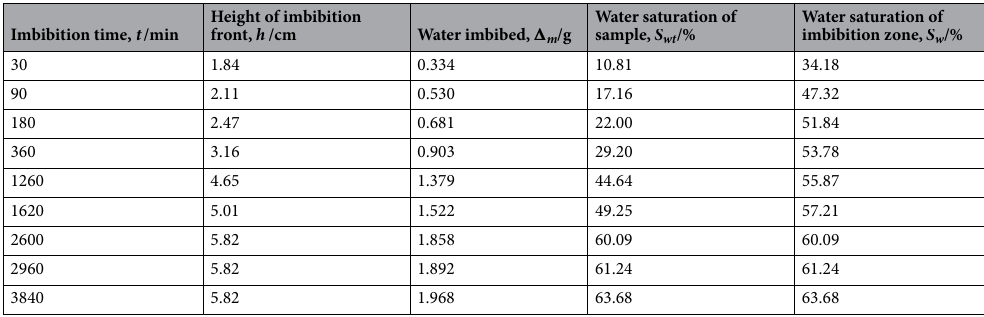
Table 2. The imbibition height and water saturation in the imbibition zone of sample S6.